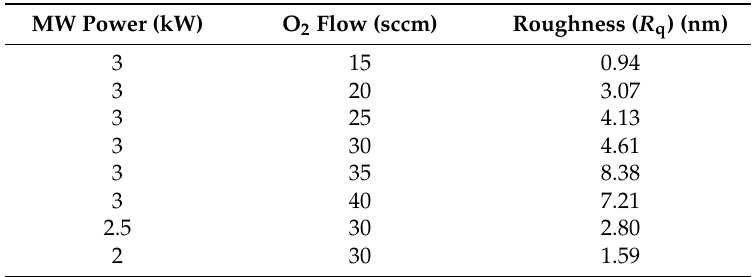
Figure 6. Atomic force microscopy (AFM) images of the samples with varying oxygen flows and microwave power. Table 2. Mean square root of surface roughness R q of TiO 2 thin films. MW Power (kW)